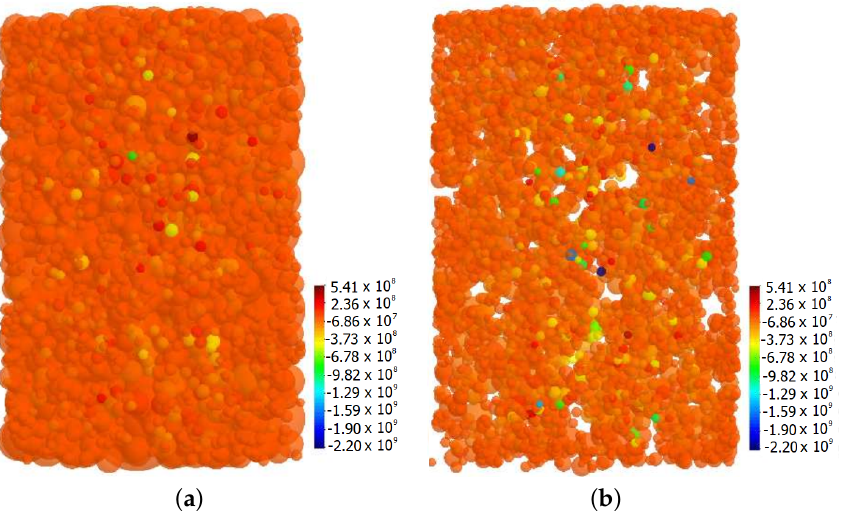
Figure 17. Graphical distribution of particle total hydrostatic stresses at the end of the process (after cooling) of ( a ) particles of intermetallic NiAl and ( b ) particles of ceramic Al 2 O 3